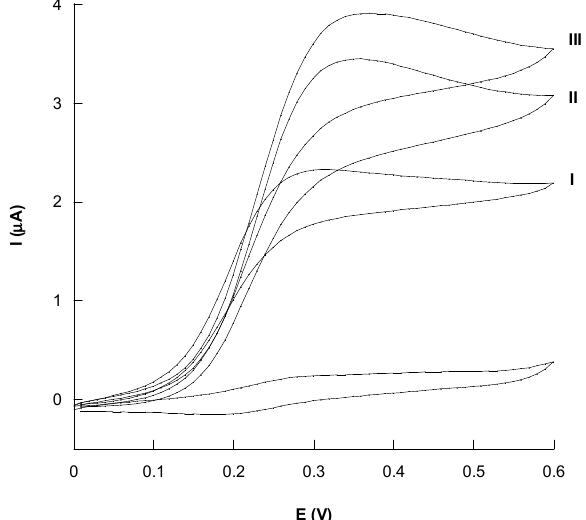
Figure 6. Voltammetric response of one (I), two (II) and three (III) biolayers of KLNPs/ConA/GOx on the Au-modified electrode in the presence of 2 mM glucose and 0.1 mM OsCmplx. Experimental conditions: PBS buffer (pH 7.4), T = 298, ν = 10 mV s − 1 .